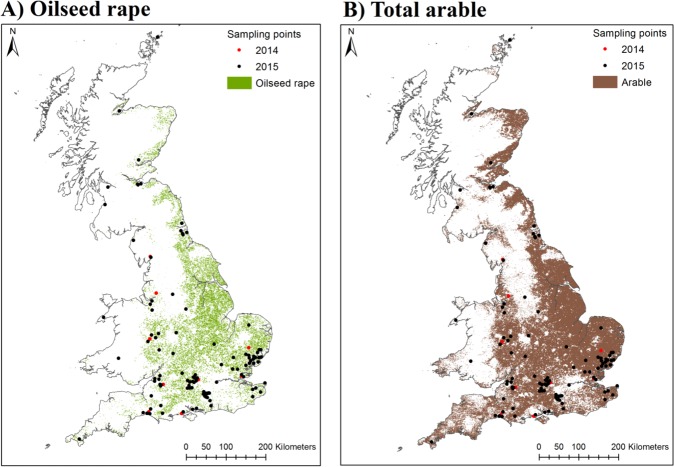
Location of UK honey samples.The two maps show the location of honey samples collected in 2014–15 superimposed over the cover of all arable crops (A) and oilseed rape (B).